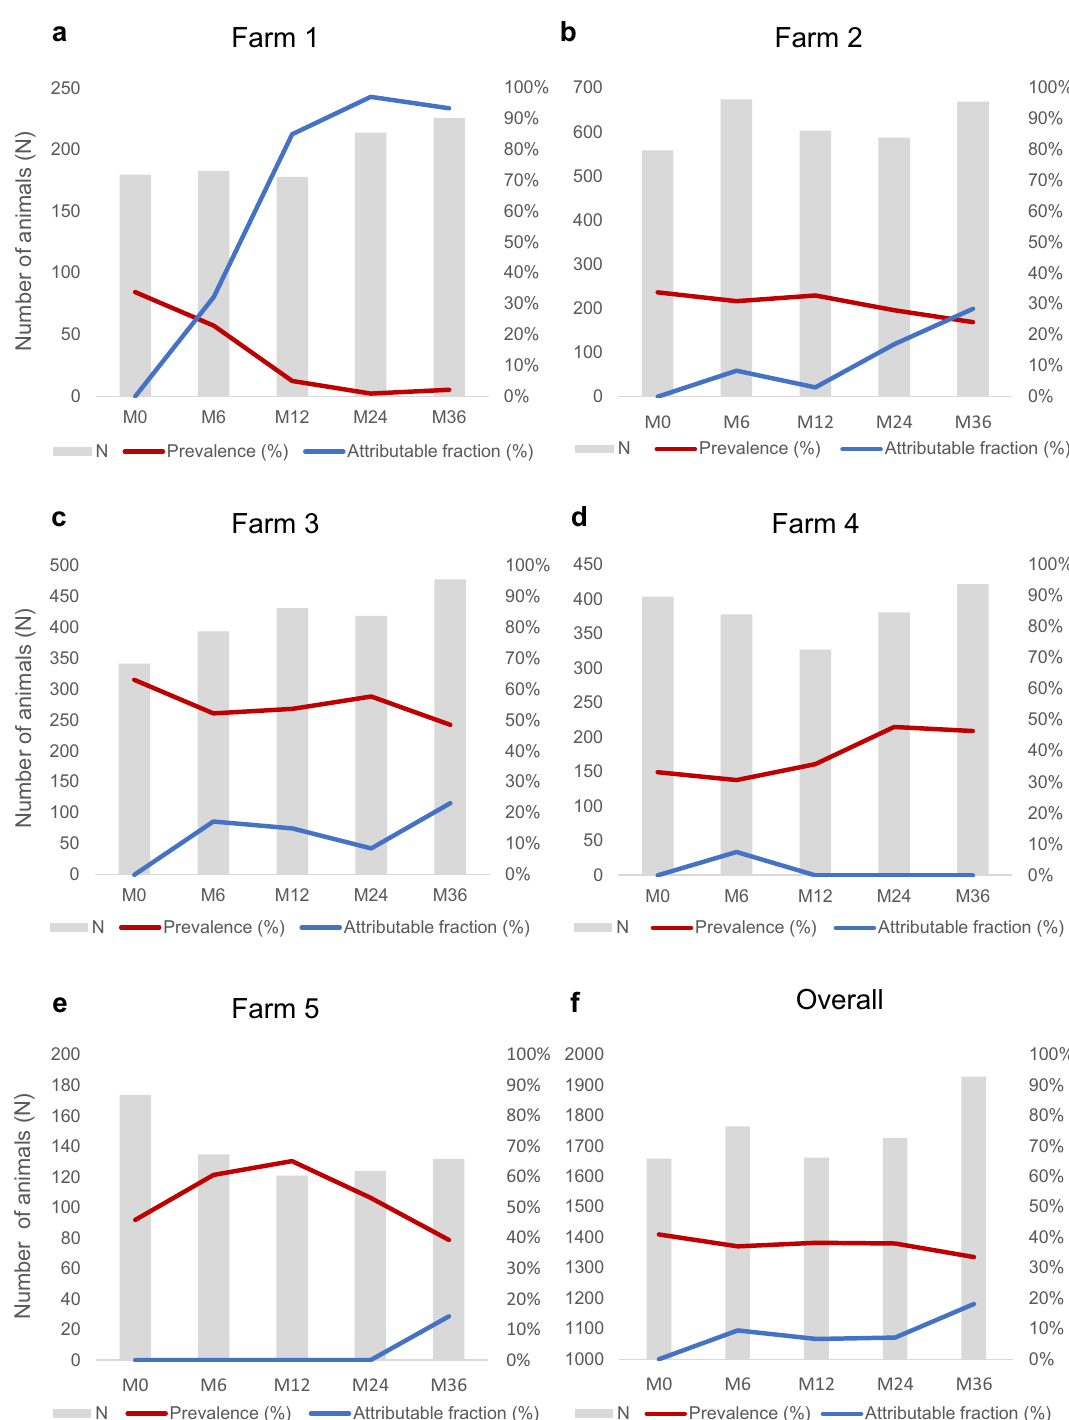
Figure 1. Evolution of prevalence throughout the BCG vaccination trial. Evolution of census (grey bars), prevalence (red lines) and percentage of prevalence reduction (blue lines) in farms 1 ( a ), 2 ( b ), 3 ( c ), 4 ( d ) and 5 ( e ), and overall reduction of five farms ( f ). The prevalence was measured as the percentage (%) of TB positive animals = number of TB positive goats / total census. The reduction of prevalence was measured as attributable fraction (AF) = (% of TB positive at M0—% of TB positive at M6 or M12 or M24 or M36) / % of TB positive at